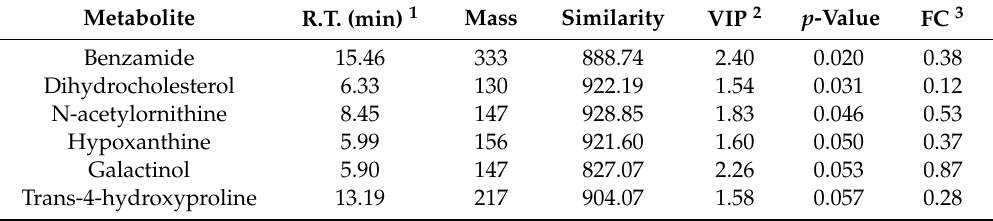
Table 7. List of significantly changed metabolites between the Con group and the AB group.